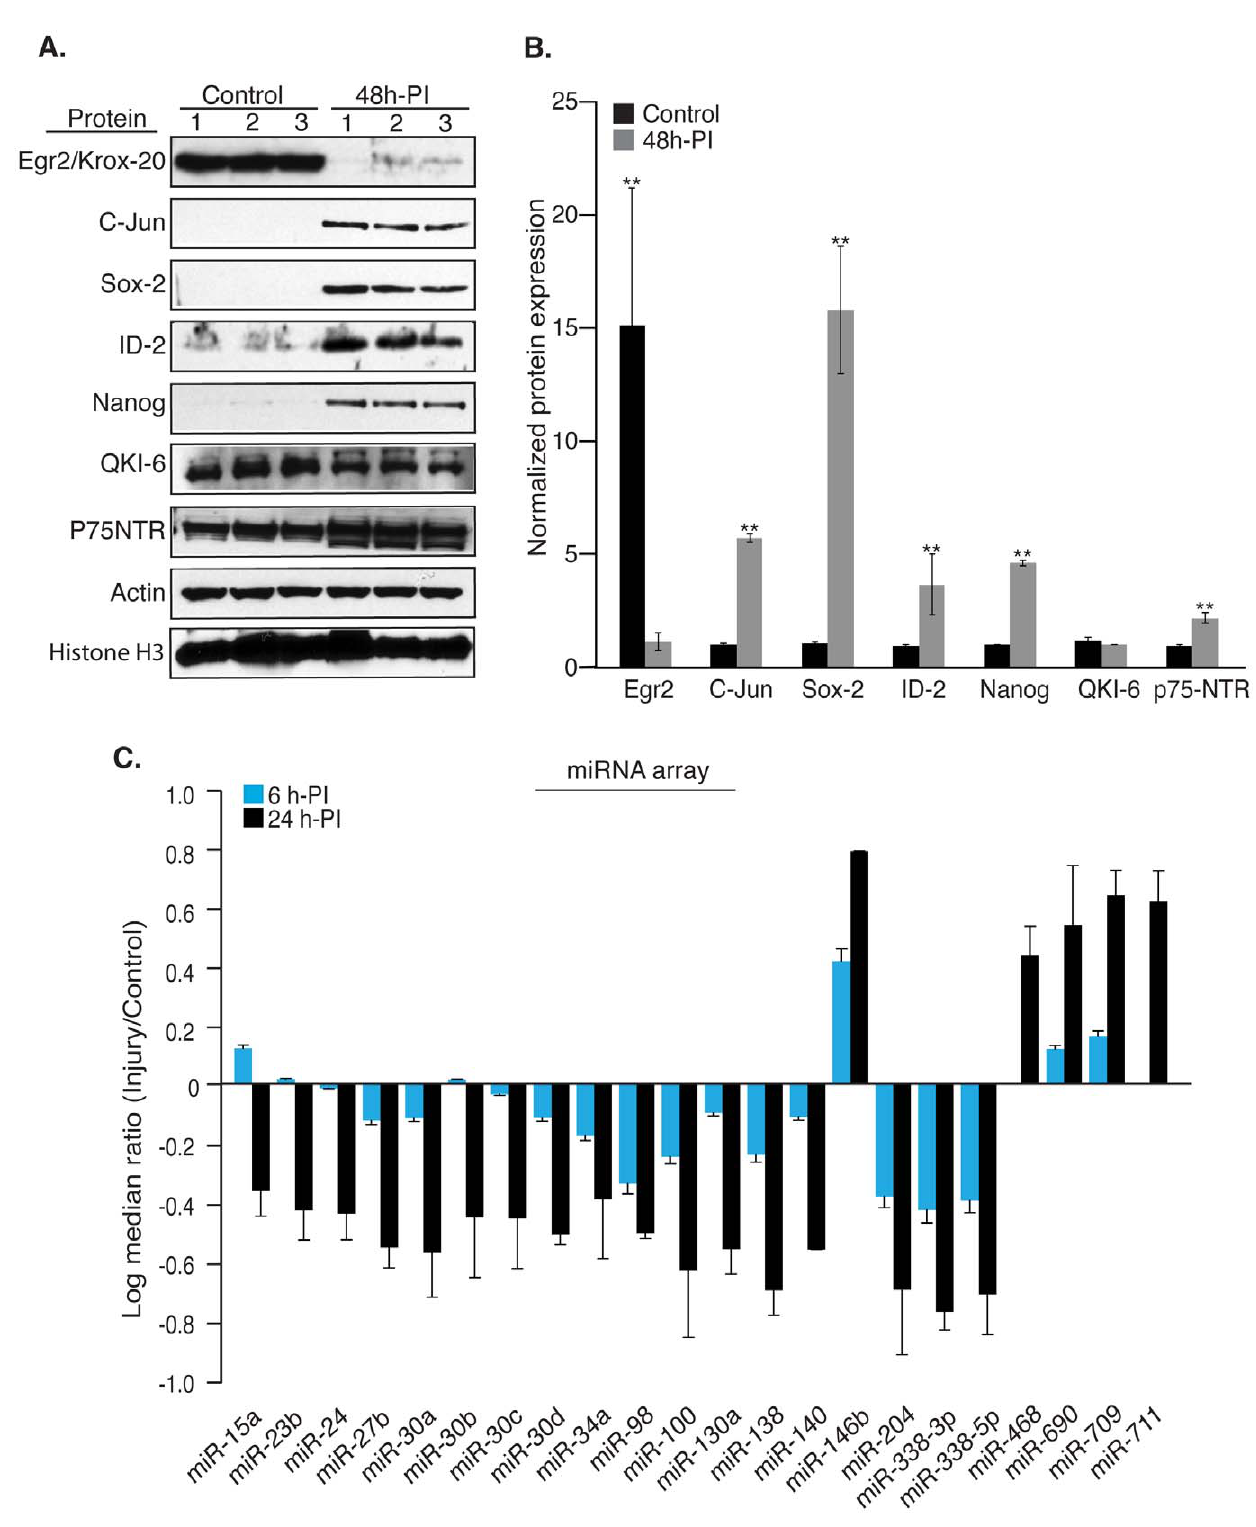
Figure 1. Protein expression changes and miRNA expression profile following invivo sciatic nerve injury. Protein expression analysis reveals a robust reduction in pro-myelination and upregulation of anti-myelination factors. All experiments were repeated three times unless otherwise stated. (A). Uninjured and distal segments of axotomized sciatic nerves at 48 hours post injury (PI) (n=4) were lysed in SDS buffer and western blots were performed for Egr2 (63 kDa), C-Jun (43 kDa), Sox-2 (35 kDa), ID-2 (15 kDa), Nanog (34–40 kDa), QKI-6 (38 kDa), P75 NTR (75 kDa), beta-actin (42 kDa) and Histone H3 (17 KDa). (B). Relative protein levels normalized to beta-actin were plotted to demonstrate the differential expression of the pro-myelination and anti-myelination factors in injury. Statistical significance was calculated with a Student’s t-test (**: p , 0.001). (C). Microarray for miRNAs (version 9.2) was performed using total RNA from 15 control and 15 axotomized mouse sciatic nerves at 6 hours and 24